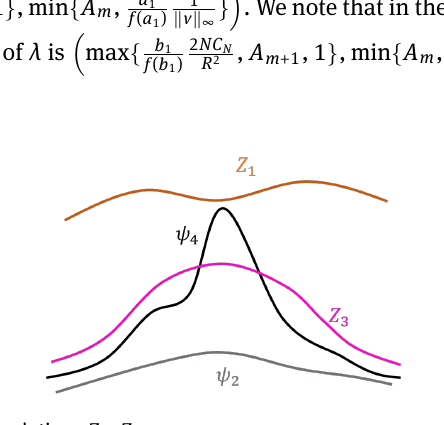
Fig. 7: Subsolutions ψ 2 , ψ 4 and supersolutions Z 1 , Z 3